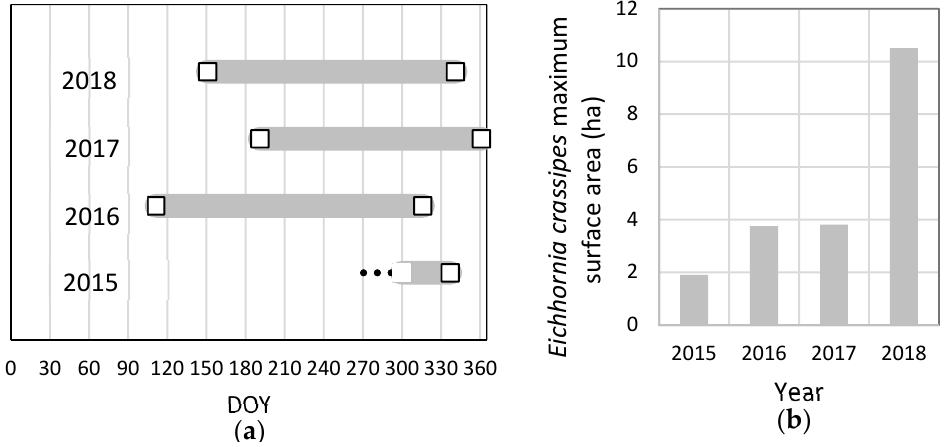
Figure 10. Interannual comparison of the development of Eichhornia crassipes. ( a ) Duration of the period of presence of Eichhornia crassipes in the river corridor. ( b ) Maximum surface area covered during the year (ha).